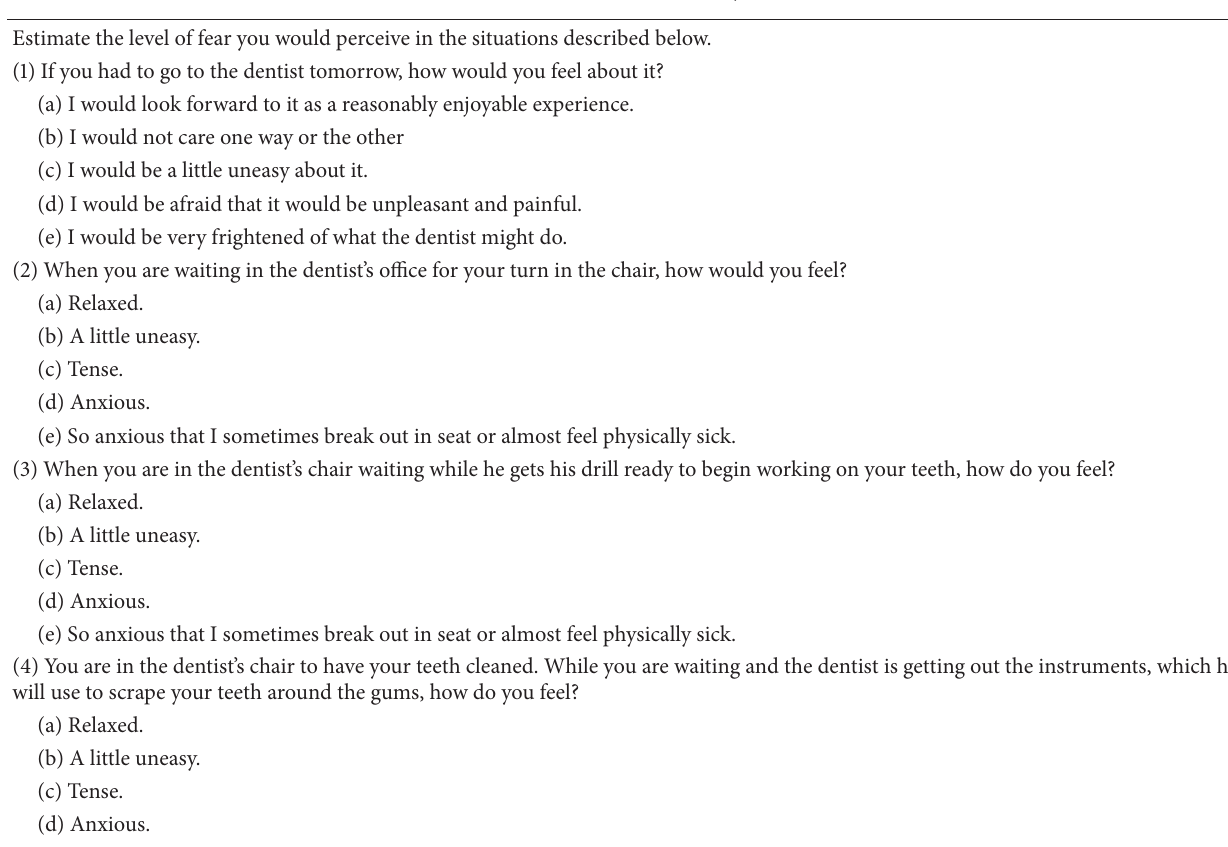
Table 2: Corah Dental Anxiety